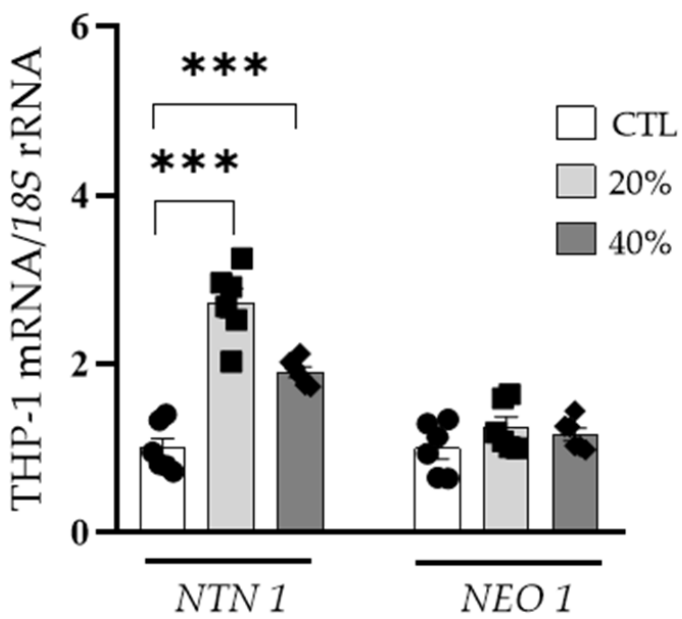
Figure 4. Effect of adipocyte conditioned medium (20% and 40%) on NTN1 and NEO1 gene expression levels in monocyte-derived macrophages. Gene expression levels in unstimulated cells were assumed to be 1. Differences between groups were analyzed by one-way ANOVA followed by Dunnett’s post hoc tests. *** p < 0.001. CTL, control.